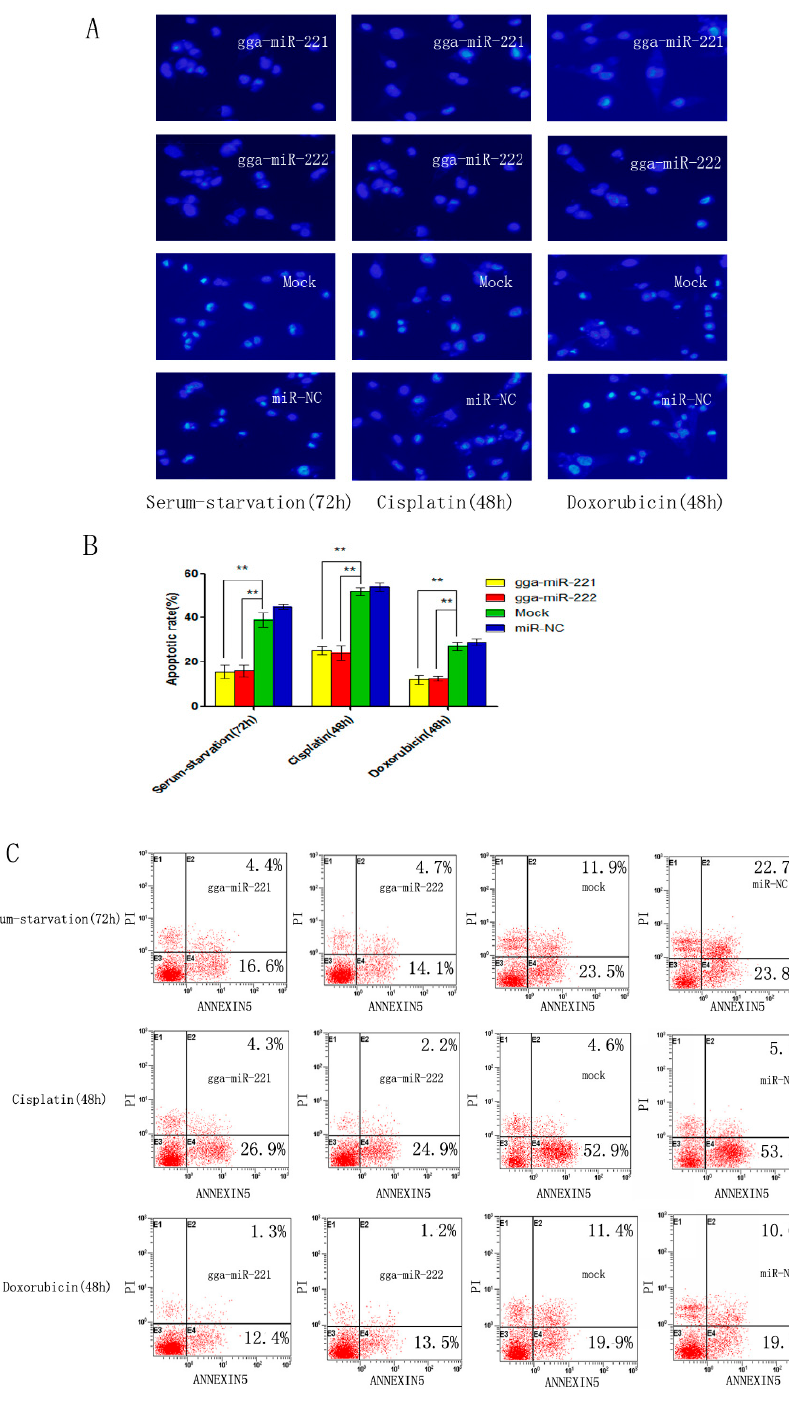
Figure 3. gga-miR-221 and gga-miR-222 inhibit apoptosis induced by serum starvation, cisplatin, and doxorubicin. Cells were transfected with gga-miR-221, gga-miR-222, miR-NC, or mock transfected and then stained with DAPI. ( A ) The rates of apoptosis were evaluated by assessing the apoptotic morphology of the cells. Magnification is 200× ( B ) The differences in the rate of apoptosis between gga-miR-221, gga-miR-222, miR-NC, and mock transfected cells are shown. The graphs show the means and standard errors from three independent experiments ** p < 0.01. ( C ) The cells transfected with gga-miR-221, gga-miR-222, miR-NC, or mock transfected and then stained with Annexin V-FITC/PI 48 or 72 h post-transfection.